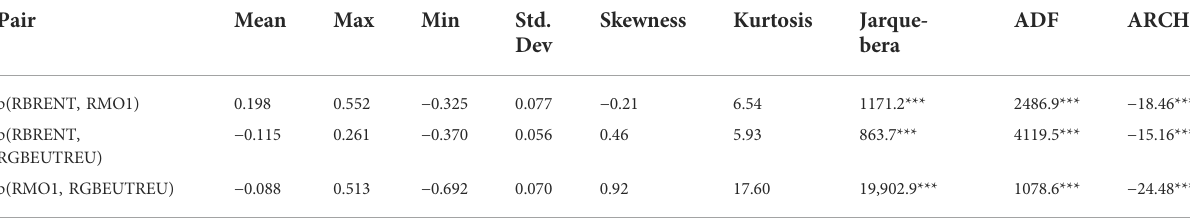
TABLE 6 Descriptive statistics of rho ( ρ ) coef fi cients obtained from DCC-Garch models. Pair Mean Max Min Std.